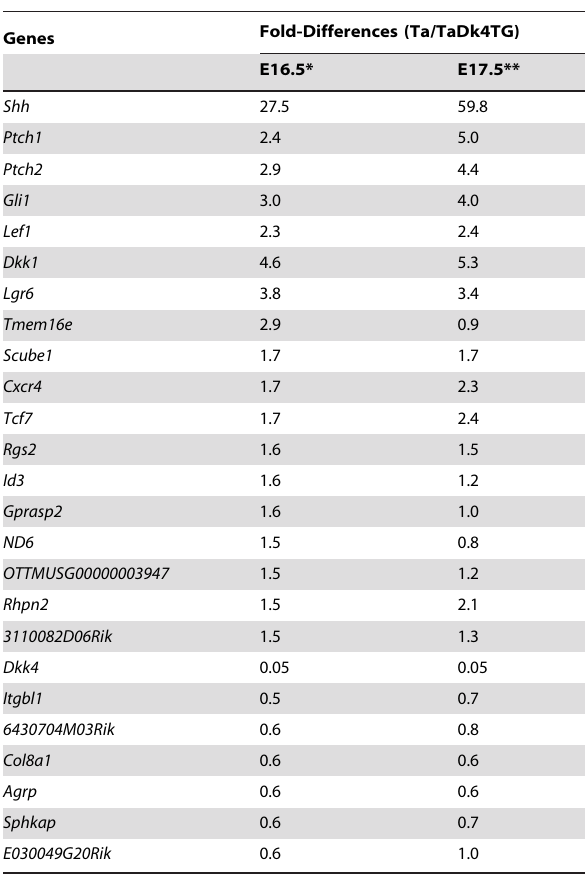
Table 1. Affected genes in TaDk4TG skin at E16.5 and E17.5.